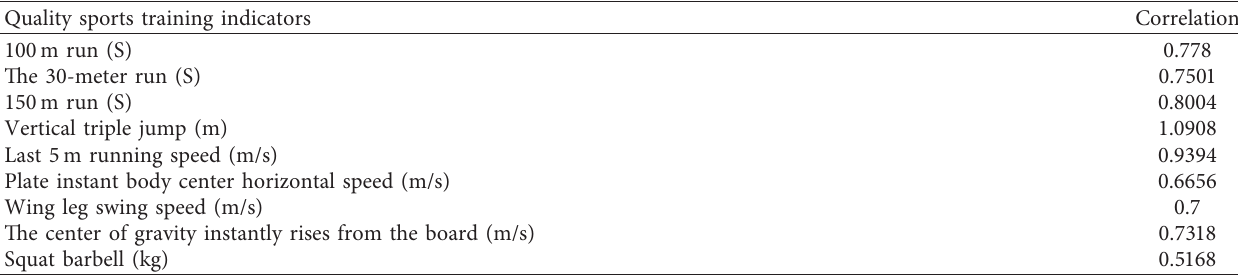
Figure 5: CAD auxiliary intelligent technology architecture. Table 1: Correlation coefficient between quality sports training index and special long jump